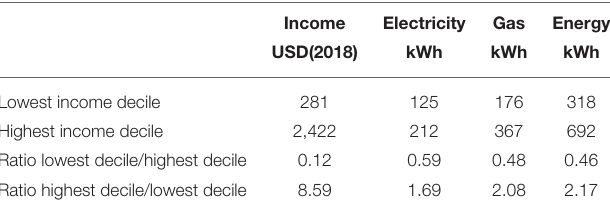
TABLE 3 | Differences in the median monthly household energy consumption between highest and lowest income